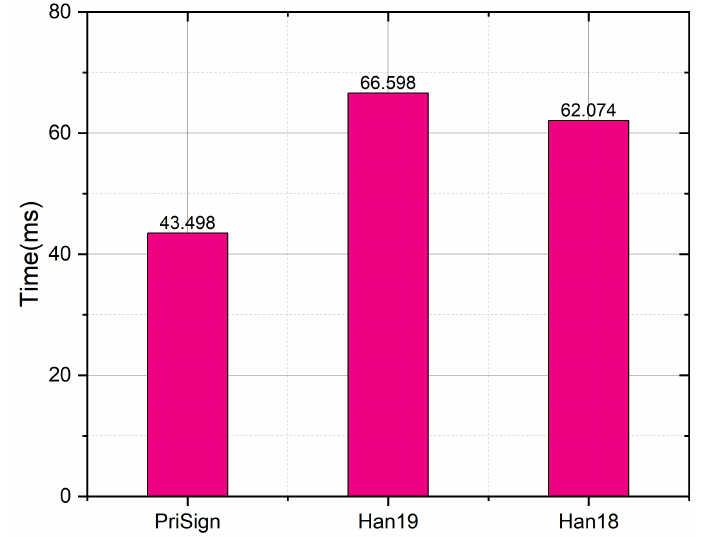
Figure 15. Time comparison with Han19 [9] and Han18 [8] in ObtTkt.U